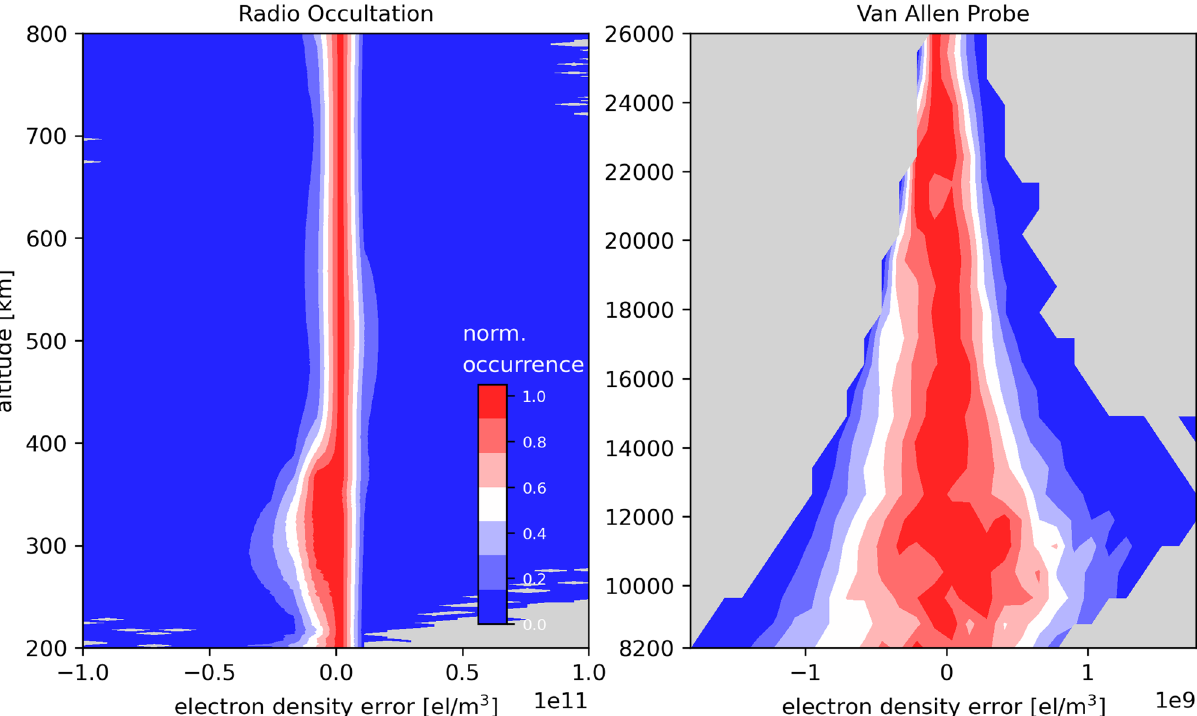
Figure 5. Distributions of the N e discrepancies between: the developed method and RO measurements (left panel); the developed method and Van Allen Probes data (right